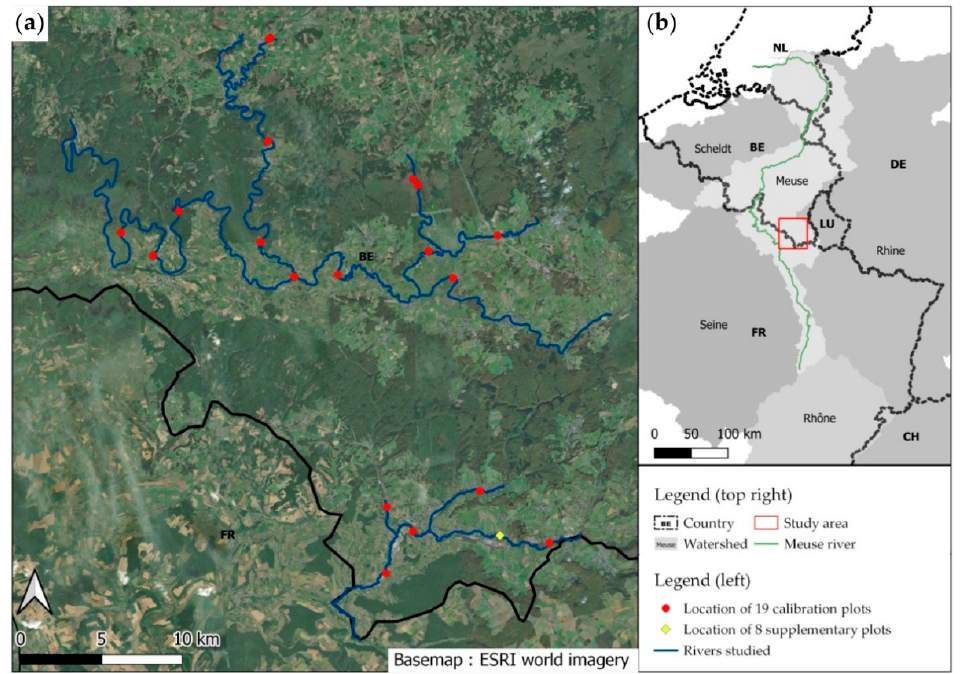
Figure 1. ( a ) Study area and inventory plots. ( b ) Location of study area within the Meuse catchment